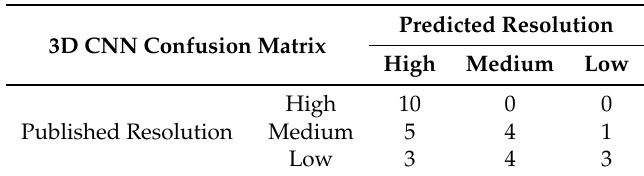
Table 4. CNN confusion